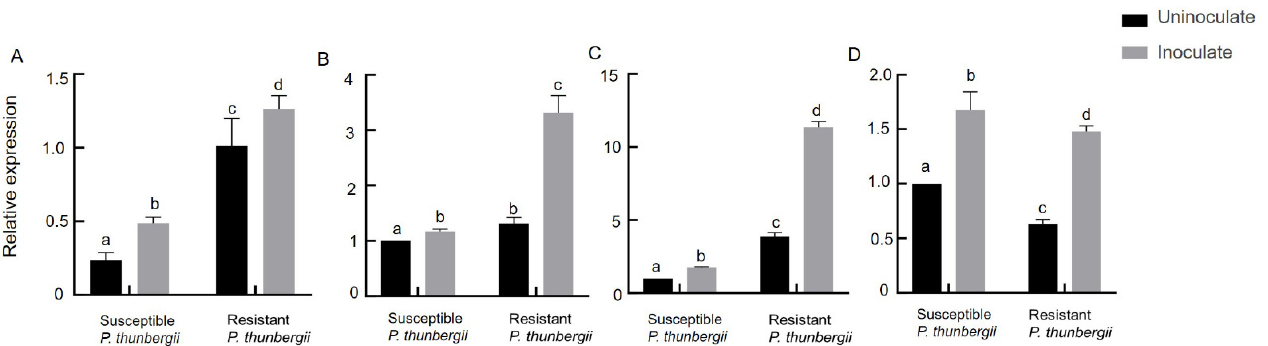
Figure 5. Expression levels of GGPPS , HDMH1 and PT genes of P. thunbergii with different levels of resistance after inoculation with PWNs ( A ) GGPPS ( B ) HDMH1 ( C ) PT1 , and ( D ) PT2 . The different letters above the error bars indicate statistically significant differences ( p < 0.05) as measured by Duncan’s multiple range